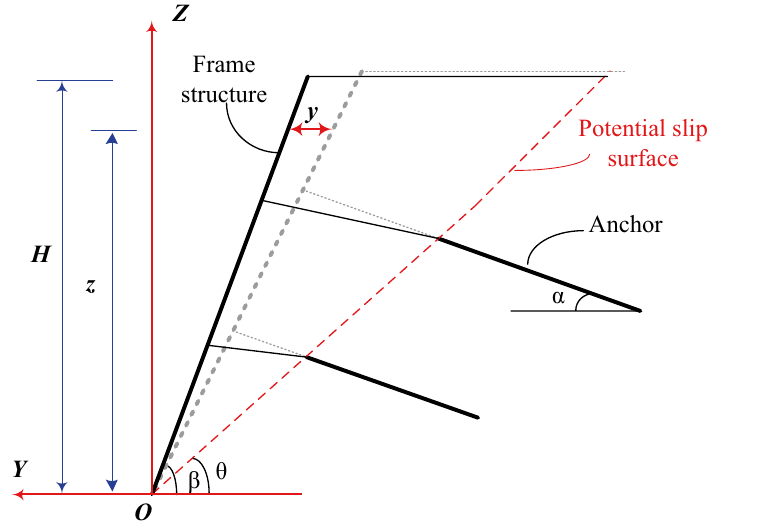
Figure 1. Horizontal displacement calculation